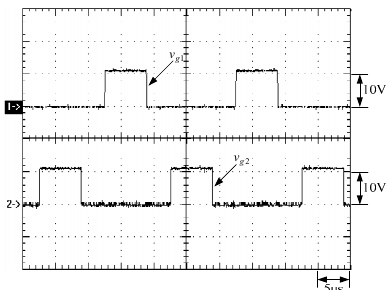
Figure 13. Waveforms pertaining to S 1 and S a at the minimum load: (1) v g 1 ; and (2) v g 2 .